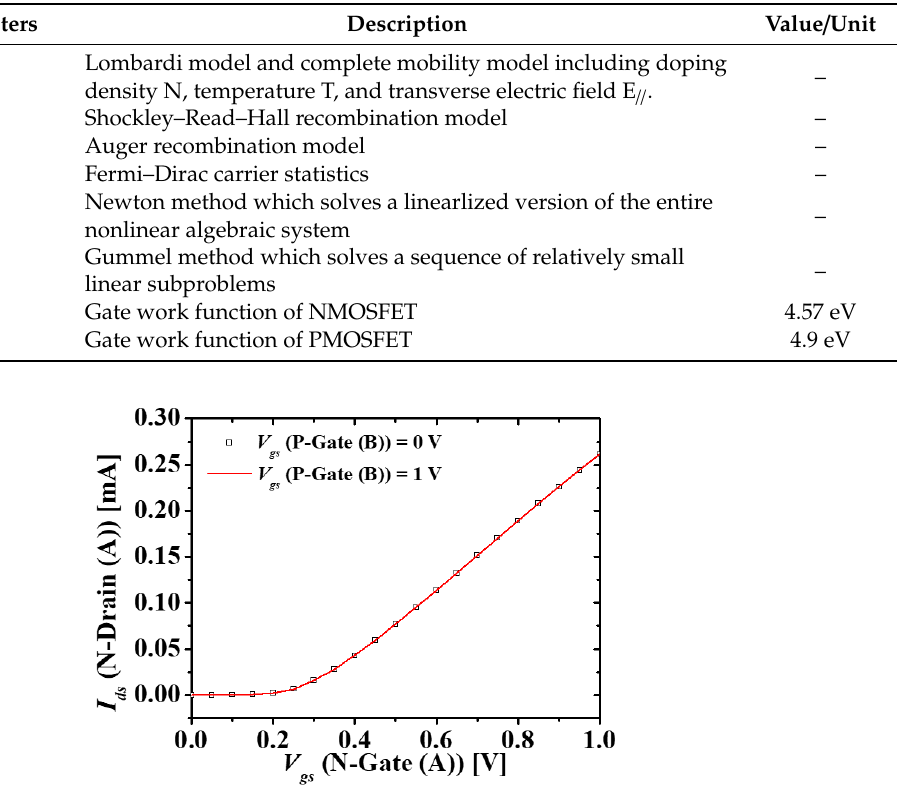
Table 1. Description and dimension of models / parameters used in technology computer-aided design (TCAD) simulation.